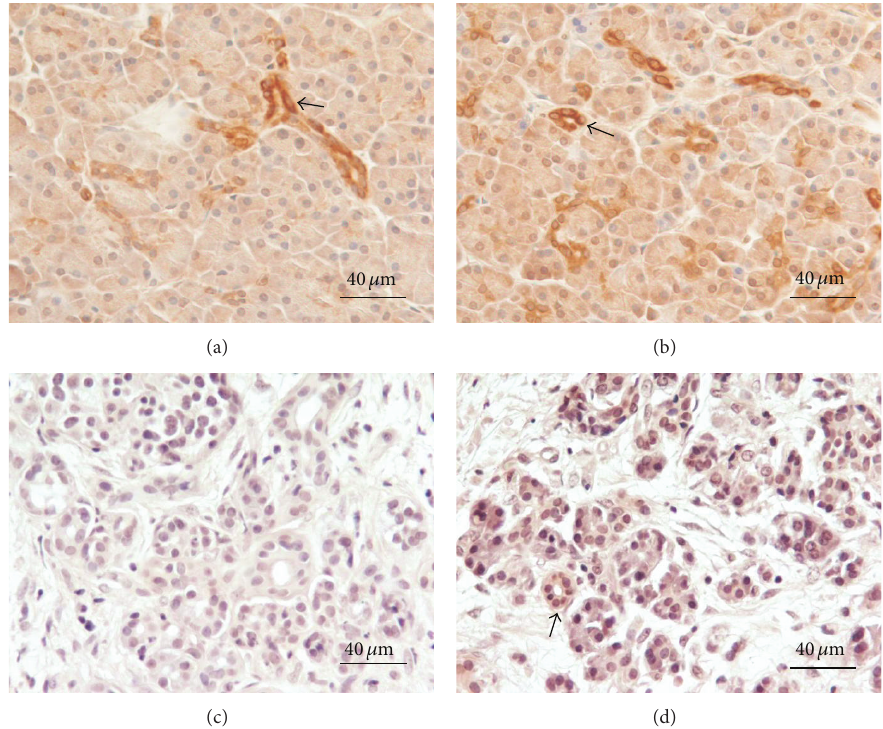
Figure 4: MCP-1 expression in acinar-cell-rich ((a), (b)) and fibrotic ((c), (d)) pancreata. Immediately after sampling, parallel portions of each tissue specimen were immersed in saline and kept at room temperature for 15 minutes ((a), (c)) or 4 hours ((b), (d)), after which they were fixed and processed for immunohistochemical analysis. MCP-1 staining was equally intense in the ductal cells of acinar-cell-rich pancreata after 15 minutes and 4 hours ((a), (b), arrows), whereas intra-acinar MCP-1 expression was observed to slightly increase with time. In fibrotic pancreata, MCP-1 in ductal and acinar cells remained undetectable at 15 minutes (c). At 4 hours, weak staining can be detected in ductal cells ((d), arrow). The slides were counterstained with